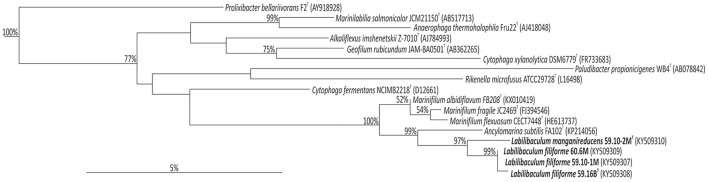
Phylogenetic tree based on 16S rRNA gene sequences of strains 59.10-1M, 59.10-2M, 59.16B and 60.6M and type strains of related species.